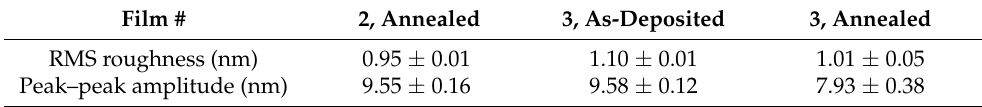
Table 2. Surface roughness from atomic force